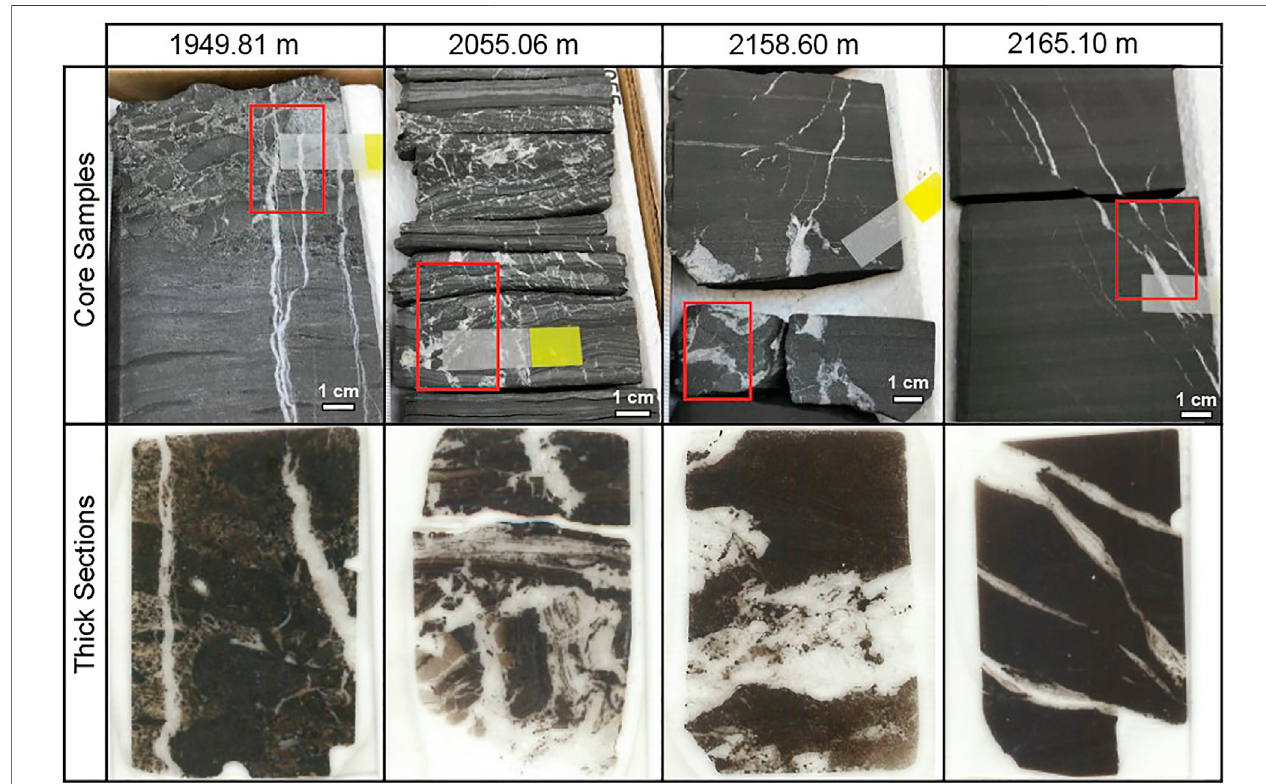
FIGURE 2 | Images of core samples and associated thick section used for fl uid inclusion analysis. Red boxes indicated region sampled for thick section.